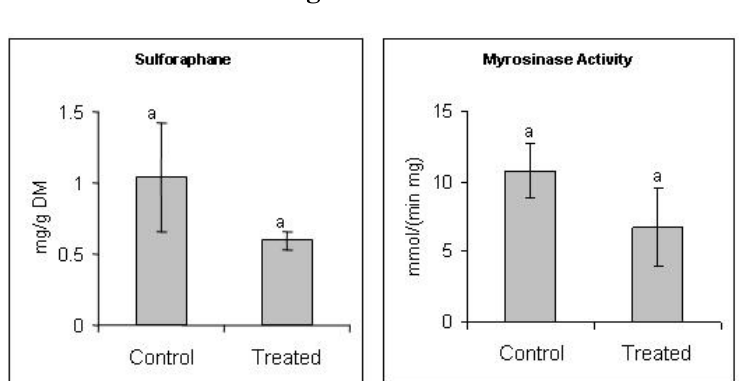
Bars represent mean values of three independent experiments ± SD. Different letters indicate significant differences ( p <